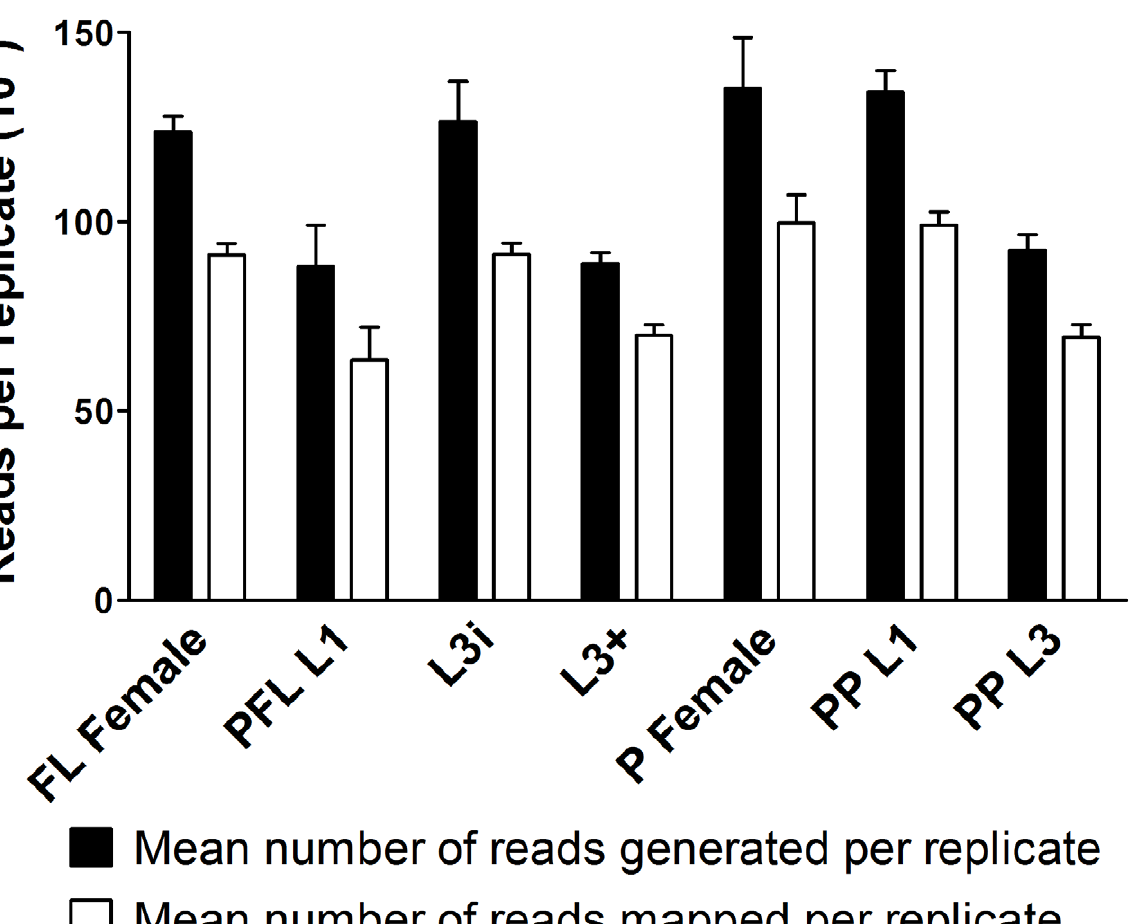
Figure 3. S.stercoralis RNAseq mean library sizes and number of reads aligning to the genome. A total of 21 libraries were derived from polyadenylated RNA and sequenced from seven developmental stages, each in biological triplicate. Paired-end 100 base-pair (bp) reads were generated from the following developmental stages: free-living females (FL Female), post-free-living first-stage larvae (PFL L1), infectious third-stage larvae (L3i), in vivo activated third-stage larvae (L3 + ), parasitic females (P Female), predominantly ( . 95%) heterogonically developing post-parasitic first-stage larvae (PP L1), and post-parasitic approximately third-stage larvae heterogonically developing to free-living adults and enriched for females (PP L3). The mean number of reads generated per replicate refers to the mean number of 100 bp reads sequenced (black bars) per biological replicate from each developmental stage. The mean number of mapped reads per replicate refers to the mean number of 100 bp reads aligned to S. stercoralis genomic contigs using TopHat (white bars) per biological replicate from each developmental stage. Error bars represent + 1 standard deviation.